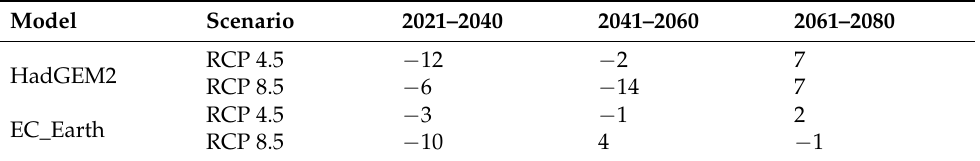
Table 4. Summary of change in sediment concentration during 2021–2040, 2041–2060 and 2061–2080 for climate scenarios: RCP 4.5 and RCP 8.5 of GCM models: HadGEM2 and